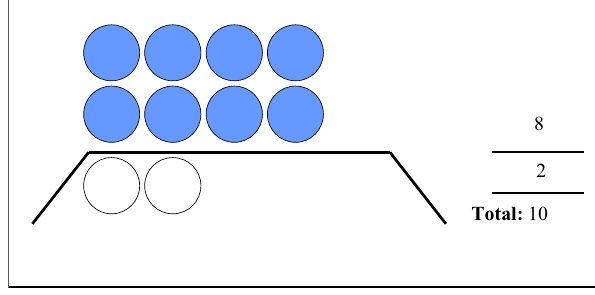
player by typing a number between 1 and 10.